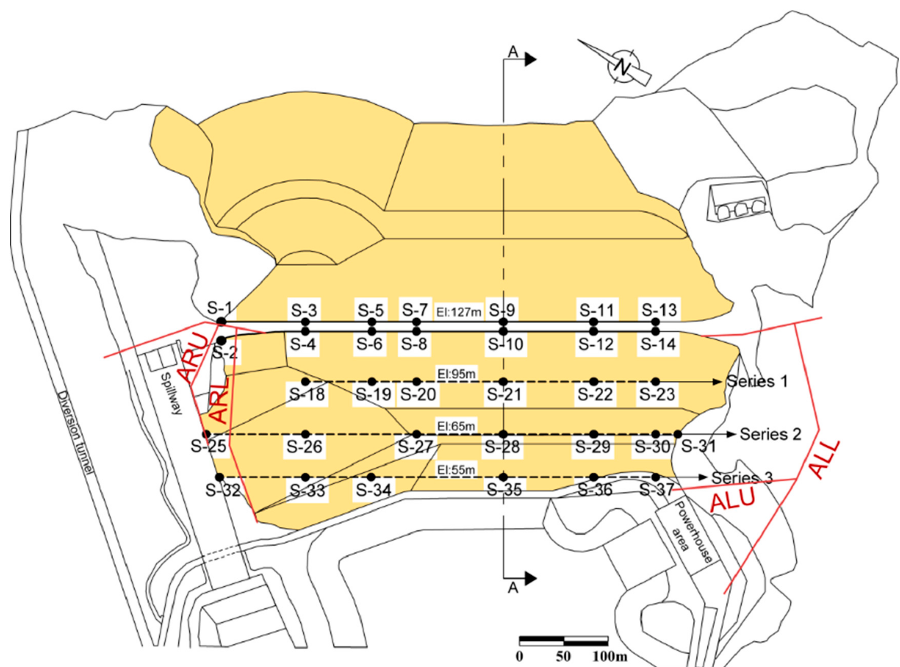
Figure 3. Part of the geodetic monitoring system at the Pournari I dam showing the control stations established on the crest and the downstream shoulder of the dam. In red are the four drainage galleries (i.e., Adit Right Abutment Upper - ARU, Adit Right Abutment Lower - ARL, Adit Left Abutment Upper - ALU, and Adit Left Abutment Lower - ALL) constructed at the dam to collect seepage. The location of the maximum cross-section A-A is also shown (modified after